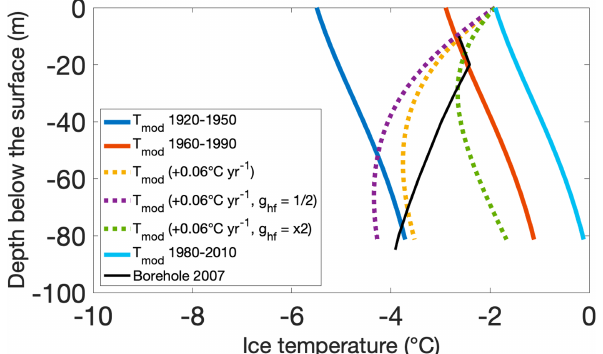
Figure 11. Measured (2007) and modelled ( T mod ) temperature profile at the summit of the Grigoriev ice cap for a fixed ge- ometry. The steady-state temperature profile is modelled for the 1920–1950, 1960–1990, and 1980–2010 mean climatic condi- tions. A time-dependent temperature profile is obtained for 1980– 2010 by increasing the surface temperature from 1920–1950 with 0.06 ◦ Cyr − 1 . The purple profile is a time-dependent temperature profile obtained by using 50% of the average geothermal heat flux, while the dashed green line corresponds to the time-dependent tem- perature profile obtained by using 200% of the average geothermal heat